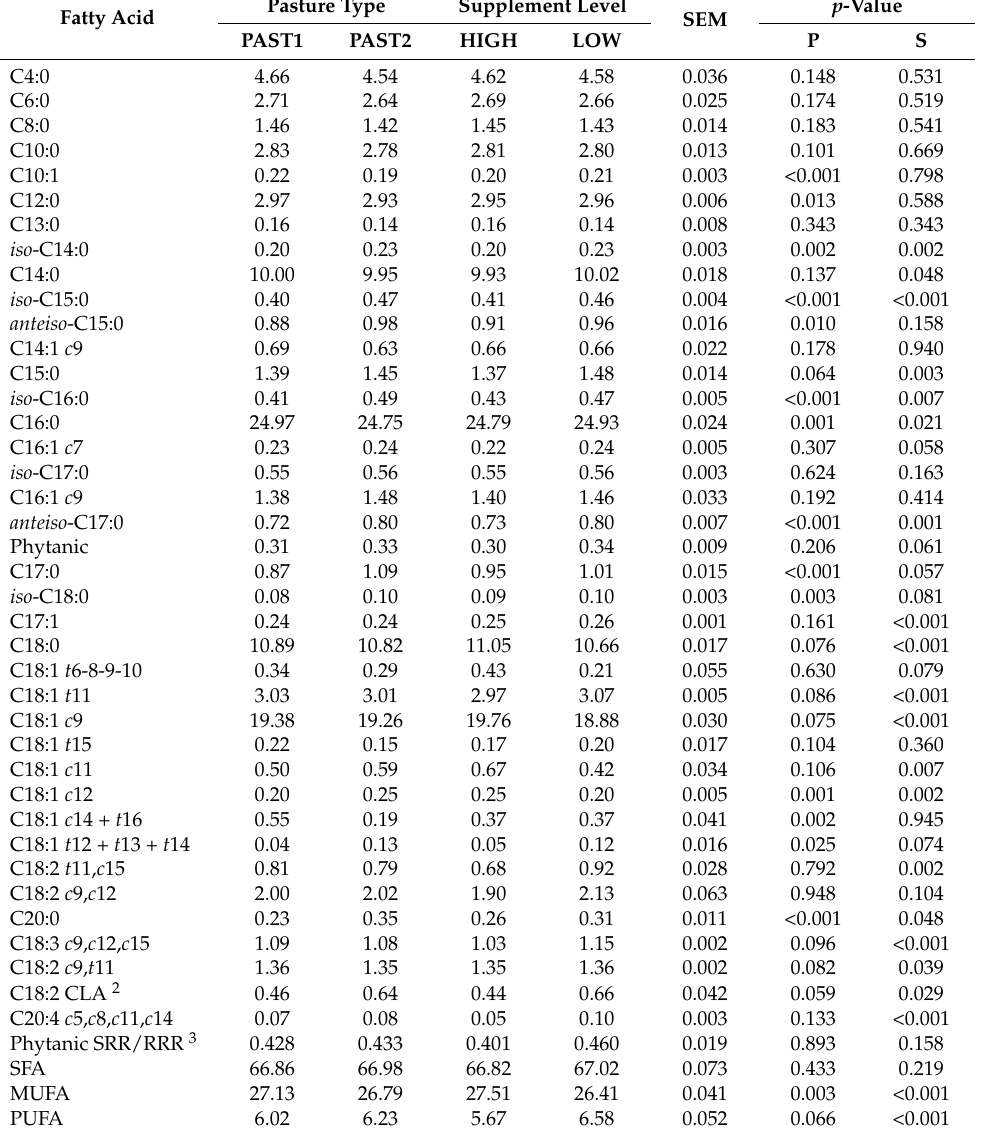
Table 2. Fatty acid composition (g/100 g of total fatty acids) of milk as affected by pasture type and supplement level; n = 12 1